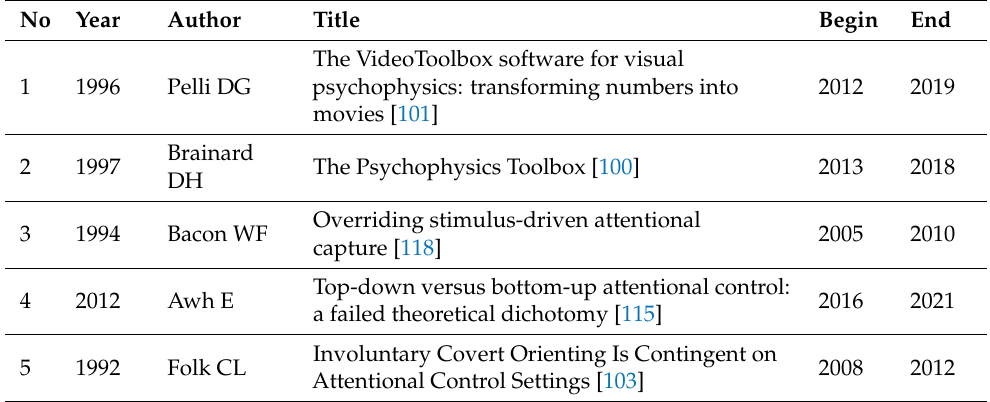
Table 5. Top 5 references with the strongest burst citation for the first step of the review, visual processing.